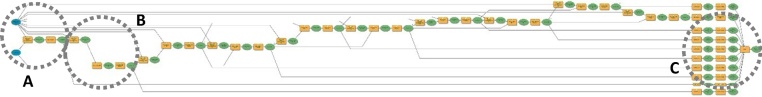
The full workflow sequences of the Stage 1 as modeled in ModelBuilder.